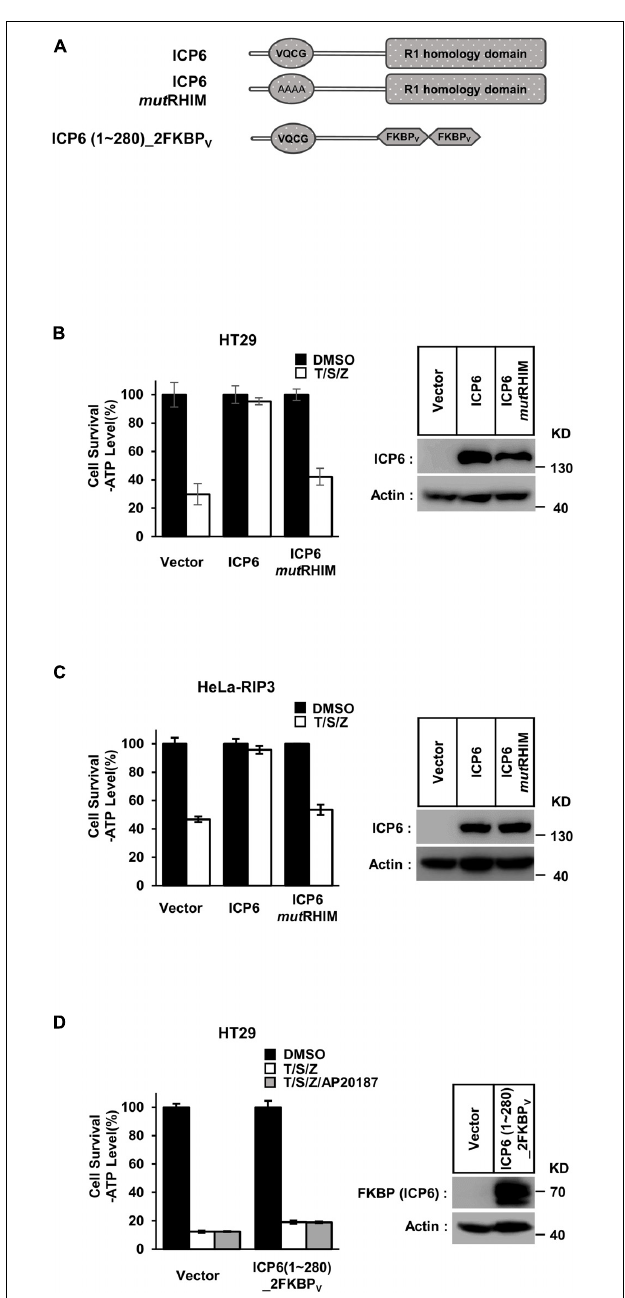
FIGURE 1 | Either RHIM or R1 domain of ICP6 is indispensable for necroptosis blockage. (A) Schematic representation of full-length ICP6 with or without RHIM mutations (upper). ICP6 N-terminal portion (1-280) was fused with tandem FKBPv domain at its C-terminus (lower). (B,C) The RHIM of ICP6 is essential for inhibition of necroptosis. The HT29 and HeLa-RIP3 (HeLa with exogenous Flag-tagged RIP3 expression) cells stably expressing ICP6 protein by lentivirus infection were stimulated with T/S/Z for 10 h. The number of surviving cells were analyzed by measuring ATP levels using CellTiter-Glo kit (left) . The data are represented as the mean ± standard deviation (SD) from at least three independent experiments. Abbreviations are as follows: T, TNF- α ; S, Smac mimetic; Z, Z-VAD. The final concentrations of 10 ng/ml TNF- α , 100 nM Smac mimetic, and 20 µ M Z-VAD were used.